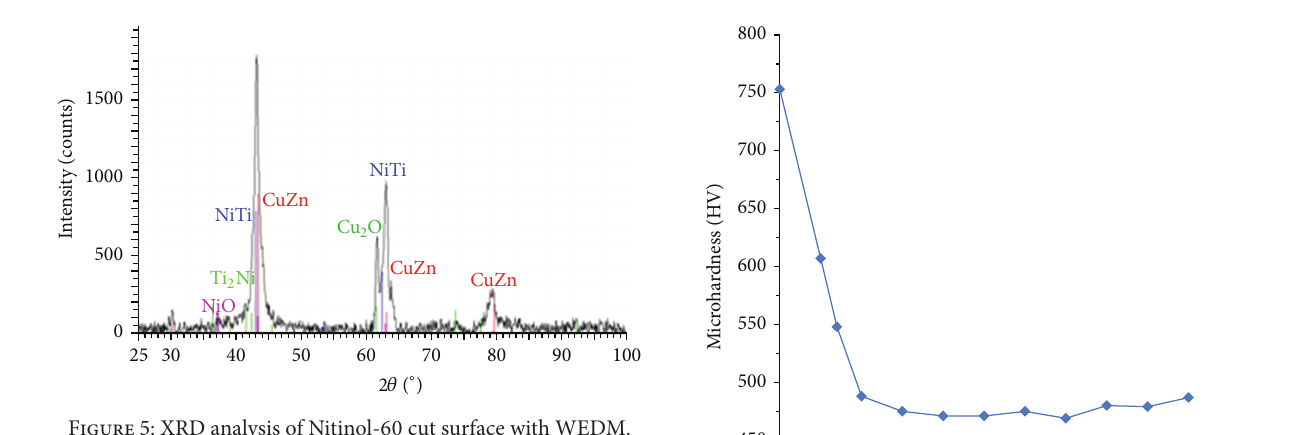
Figure 5: XRD analysis of Nitinol-60 cut surface with WEDM.